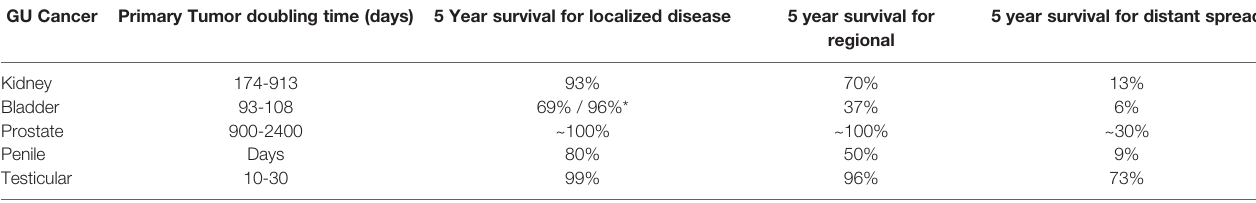
TABLE 1 | GU Tumor doubling times and their relationship to 5 year survival by disease